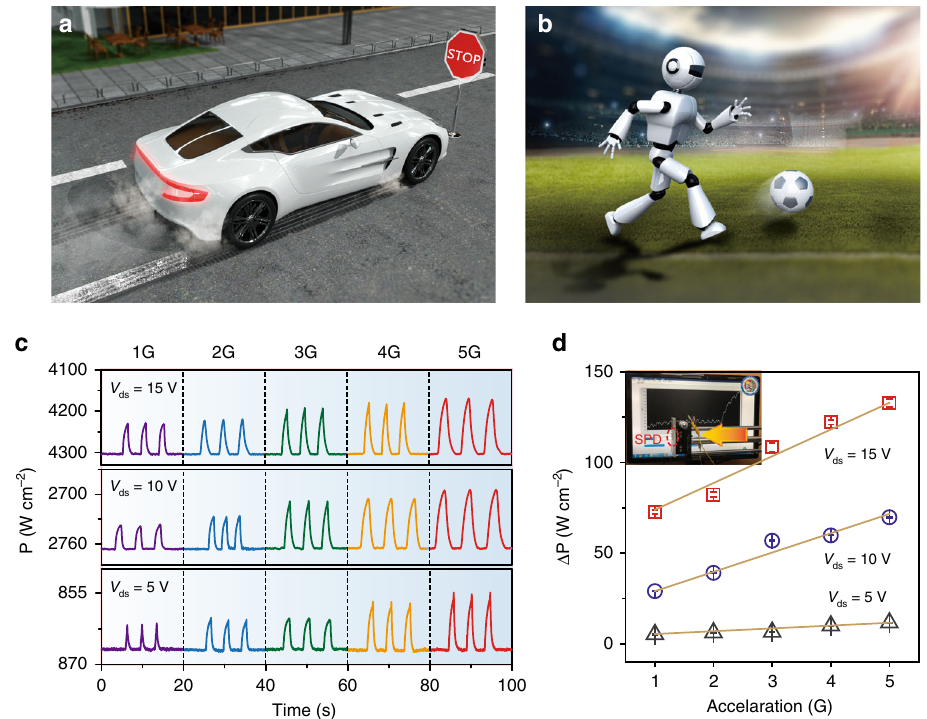
Fig. 6 Acceleration-feedback-control in the SPD. a Schematic illustration for the self-adjusted, unsupervised output power of emergency braking in a self- driving car. b Schematic illustration for the self-regulation of posture balance in robot motions, e.g., soccer robot. c Self-regulation of the output power density at real-time in response to the acceleration of 1, 2, 3, 4, and 5 G. d The changes in output power density with various acceleration. Error bars indicate standard deviations for three sets of data points. The inset shows the setup for the